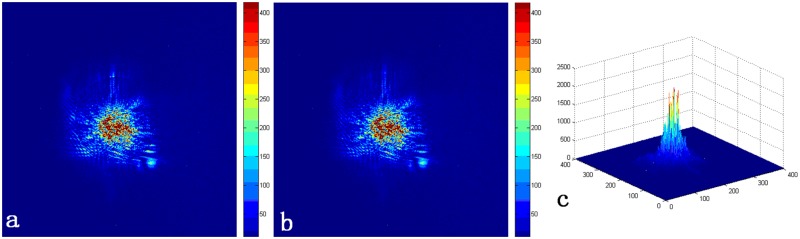
The merged image with a size of 512×512.(a) The directly merged image under the stretching effect. (b) The final merged image under the stretching effect. (c) The final three-dimensional reconstructed image.